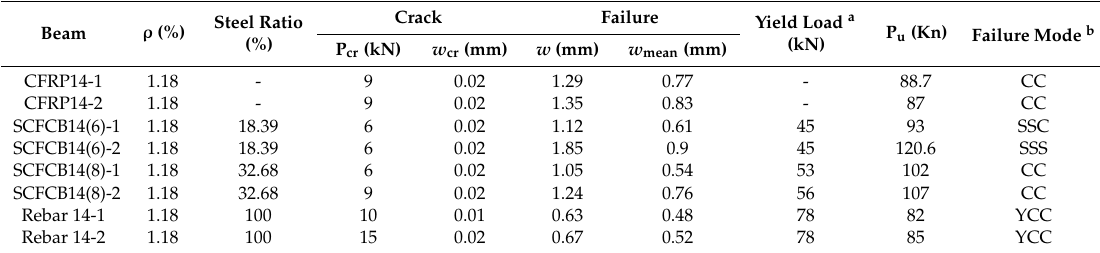
Table 3. Cracking and failure of test beam.